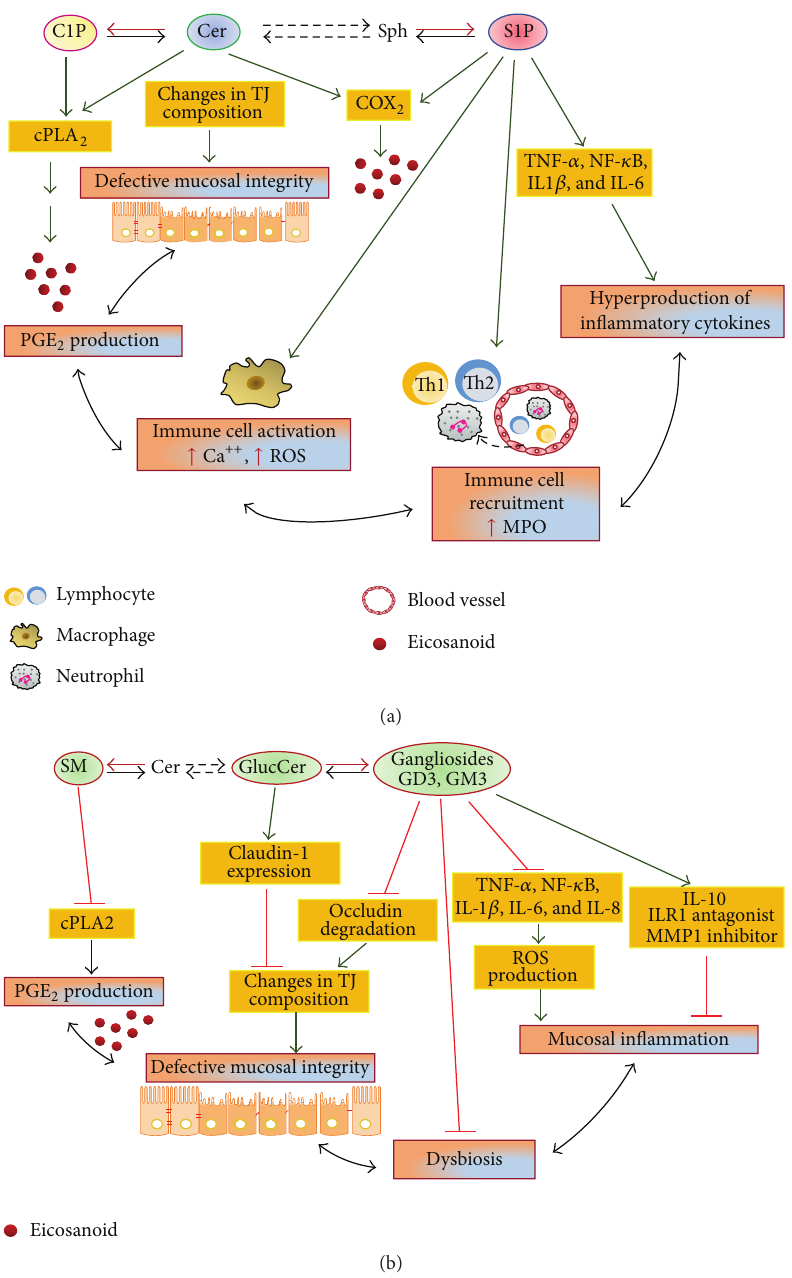
Figure 3: Inflammatory roles of sphingolipids in IBD. (a) Simple sphingolipids (C1P, Cer, and S1P) act as potent proinflammatory messengers, favoring and exacerbating the IBD condition. (b) Complex sphingolipids (SM and GSLs) exert several anti-inflammatory